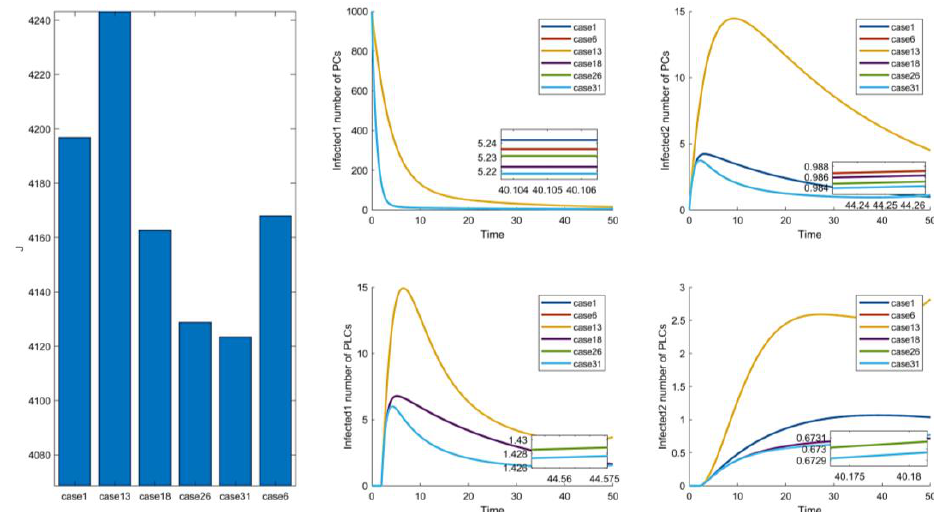
Figure 6. Costs and effects of control combinations with better effects in Figures 2 – 5.